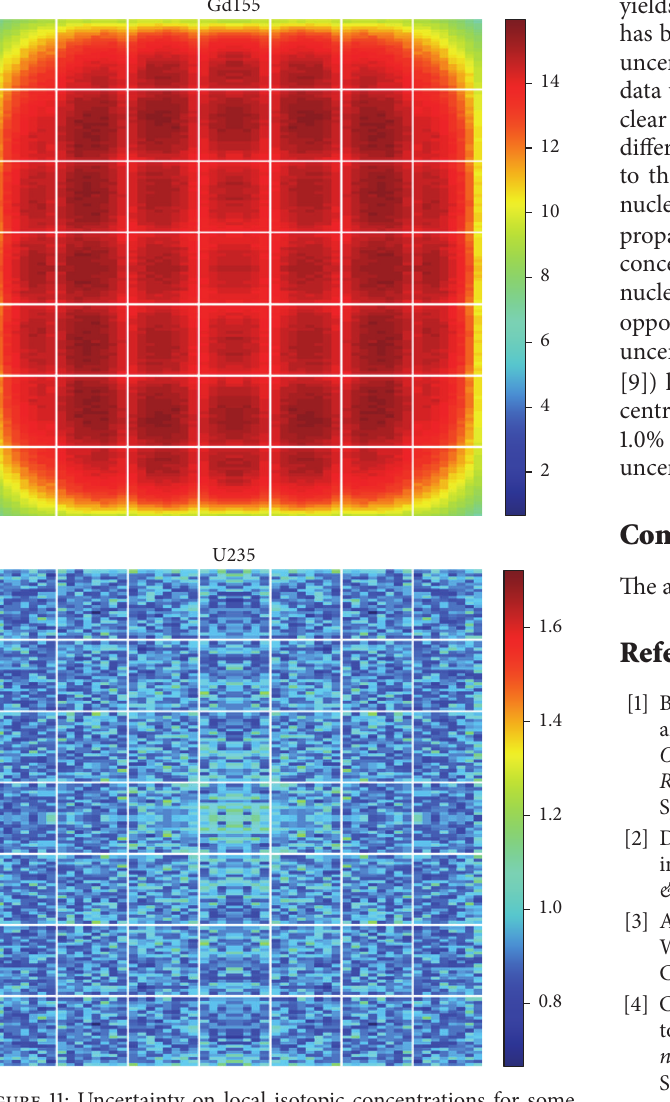
Figure 11: Uncertainty on local isotopic concentrations for some Gd155 and U235 at 48000 MW ⋅ d/t (% at 1𝜎